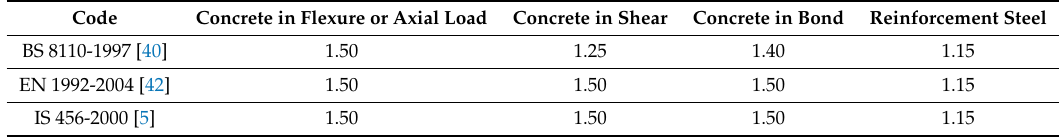
Table 2. Material Partial Factors of Safety ( γ m ) for all three